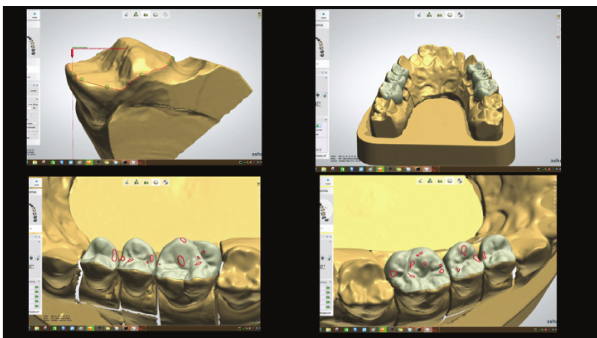
Figure 2: Case 1 (Monolithic Lithium Disilicate Onlays). After conventional impressions, the casts were scanned by a 3-Shape D700 (3 Shape, Copenhagen, Denmark) digital scanner and analyzed by means of a Dental System 15.5.0 software (3 Shape) and the restorative finish lines were detected. Then, occlusal shape design and contacts were defined.